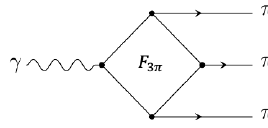
Figure 2. Coupling of a photon to three